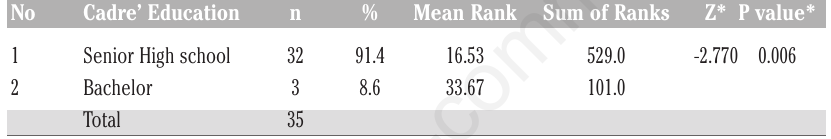
Table 3. The relationship between cadre’s education and assessing the seller’s performance in Mokoau Health Care Centre Area in 2019.